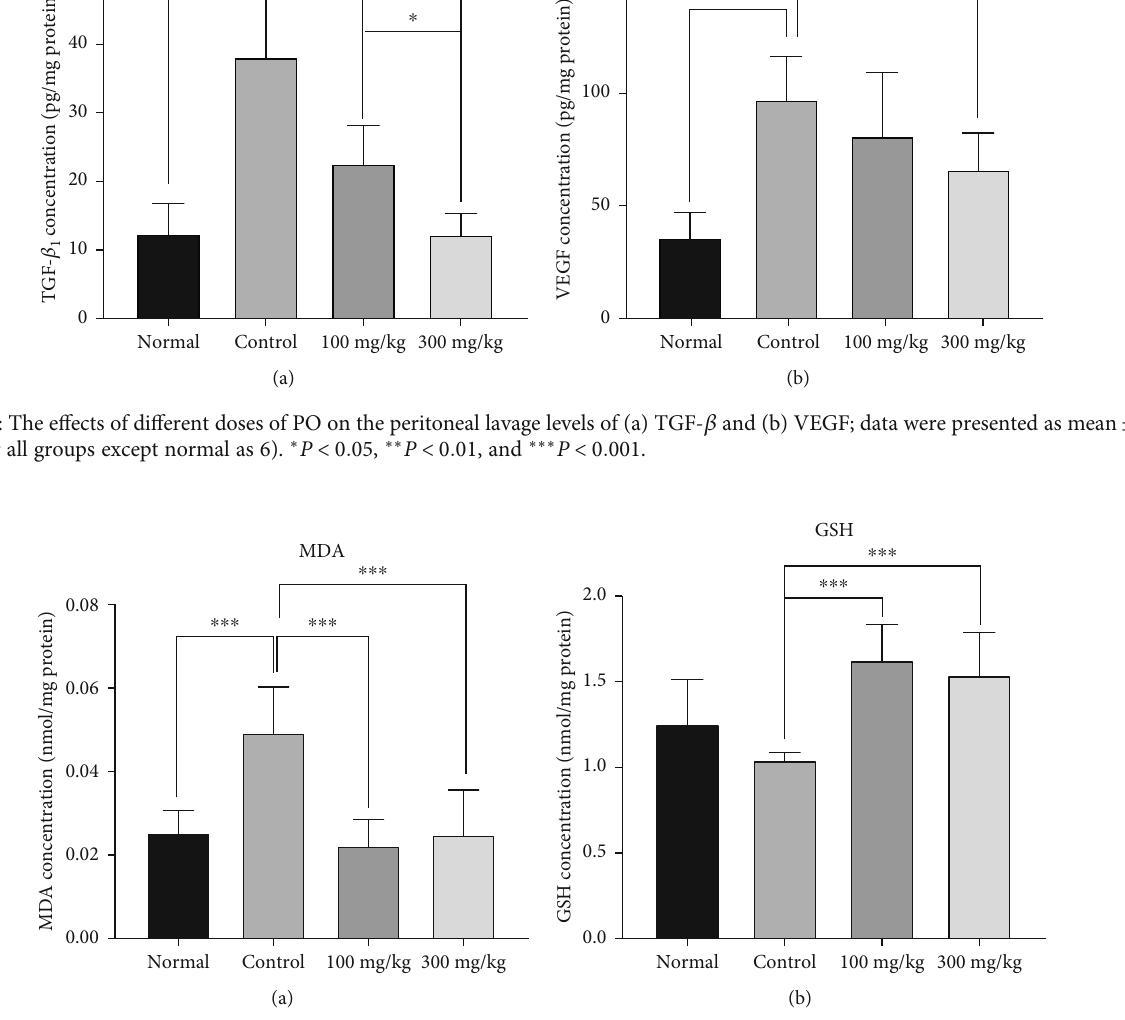
Figure 7: The e ff ects of di ff erent doses of PO on the peritoneal lavage levels of (a) MDA and (b) GSH; data were presented as mean ± SD ( n = 8 for all groups except normal as 6). ∗∗ P < 0 : 01 and ∗∗∗ P < 0 : 001